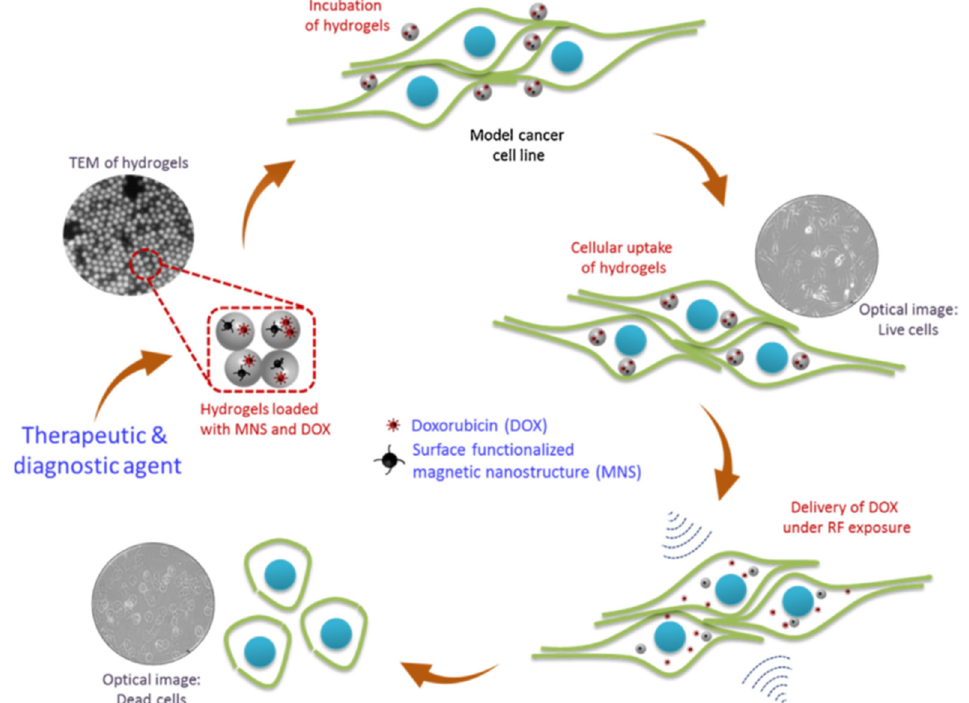
Figure 25. Schematic illustration of the anticancer activity of magnetic nanostructure (MNS) hydrogels loaded with the chemotherapeutic agent doxorubicin (DOX). The MNS was functionalized with nitro-dopamine-PEG to achieve aqueous stability. After cellular uptake, the applied external RF field activates the MNS hydrogels and stimulates DOX release by rupturing the polymeric hydrogel. Due to the presence of the MNS, the hydrogel also acts as an MRI contrast agent. Reproduced with permission from reference [94]. Copyright 2015 Elsevier.